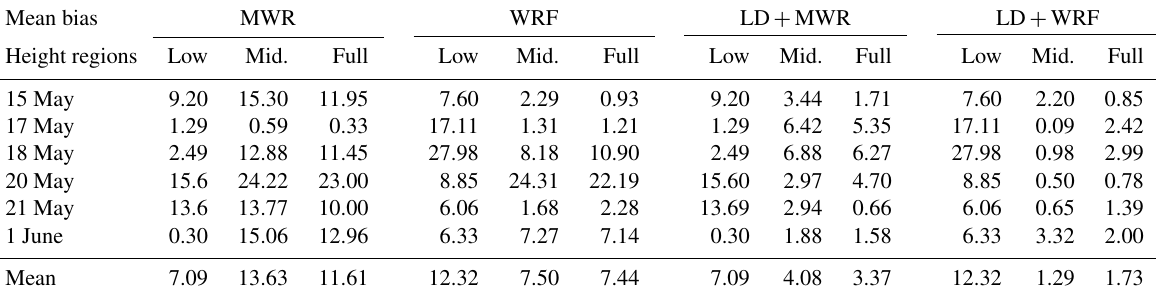
Table 3. Mean bias between various measurements techniques or simulations of relative humidity vertical profiling and high-resolution radiosounding measurements for different height regions. LD: lidar, MWR: microwave radiometer, WRF: WRF model. Mean bias